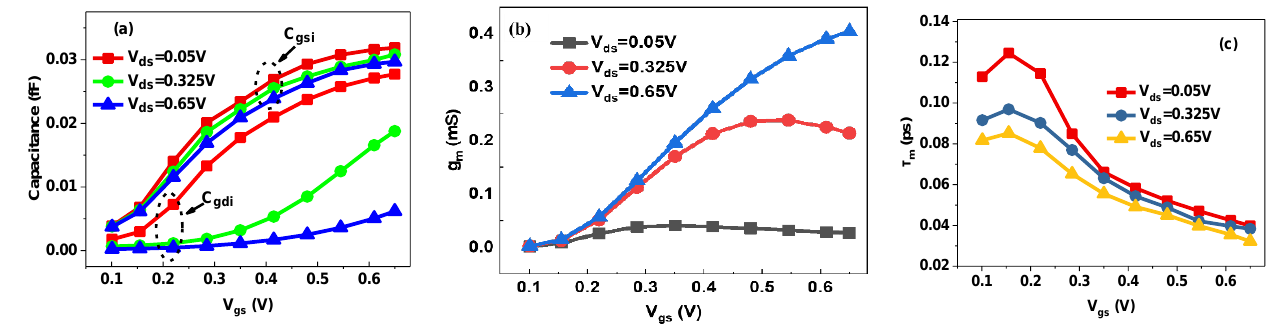
Figure 11. Variation of extracted model parameters as a function of Vgs, ( a ) C gsi and C gdi , ( b ) g m and ( c ) τ m .